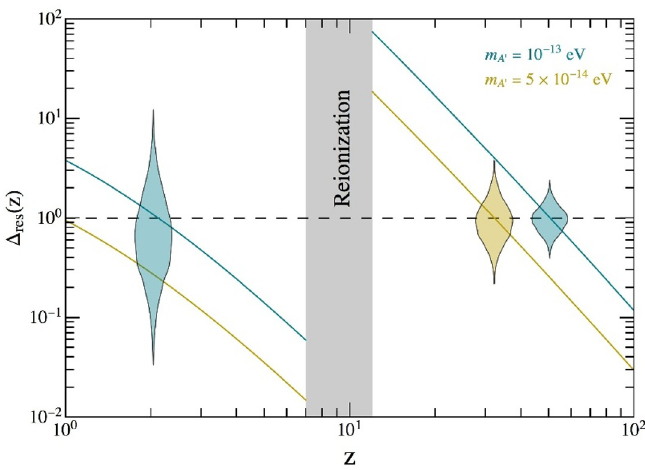
Figure 1 . Resonant over-density (cid:1) res ( z ) for various dark photon masses. Redshifts z 2 [7 ; 12] have been removed to avoid complications associated with reionization (see section 5.1 for further dis- cussion). Normalized log-normal probability distribution functions P (cid:1) evaulated at the redshift(s) z res ((cid:1) b = 1) are shown for comparison.